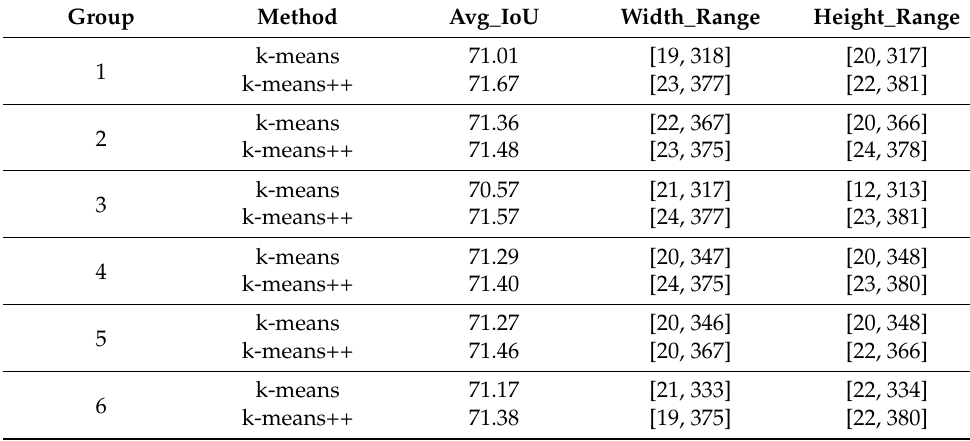
Table 3. The degree of matching and the distribution range of the prior boxes.